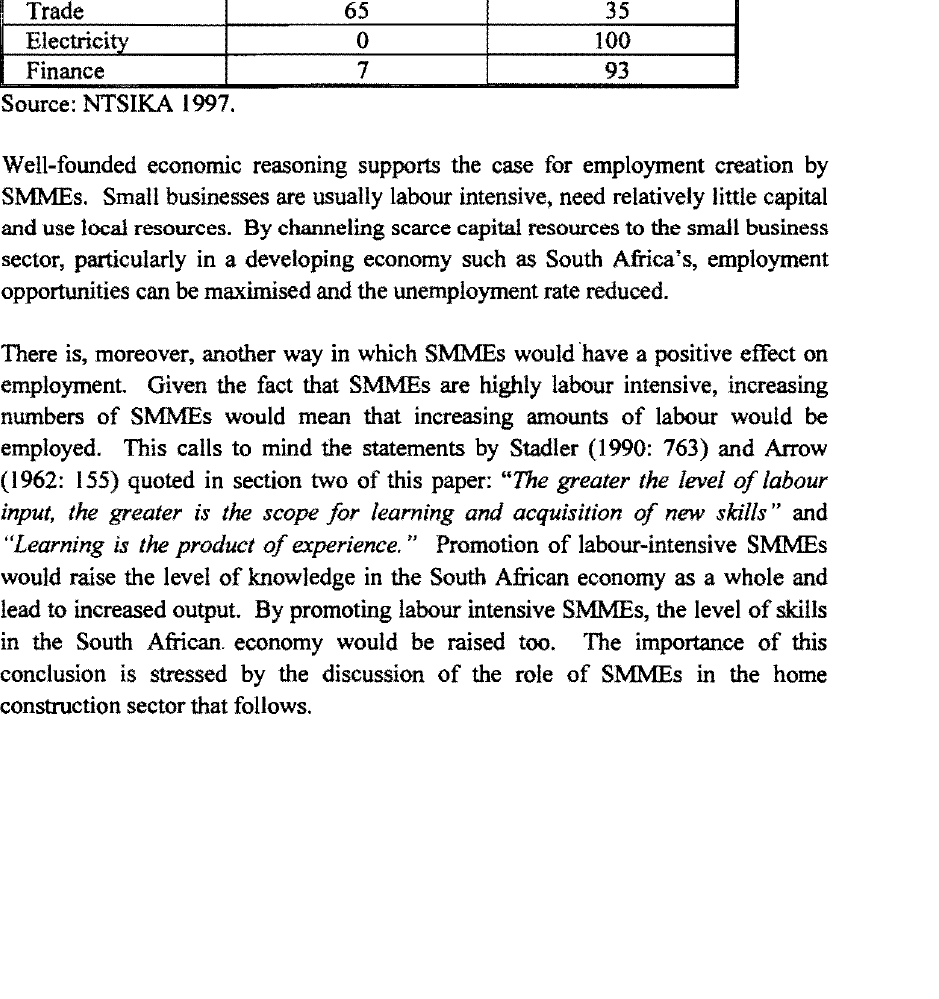
Contribution of SMMEs towards GDP by sector (as a percentage of the total contribution of eacb sector): 1995